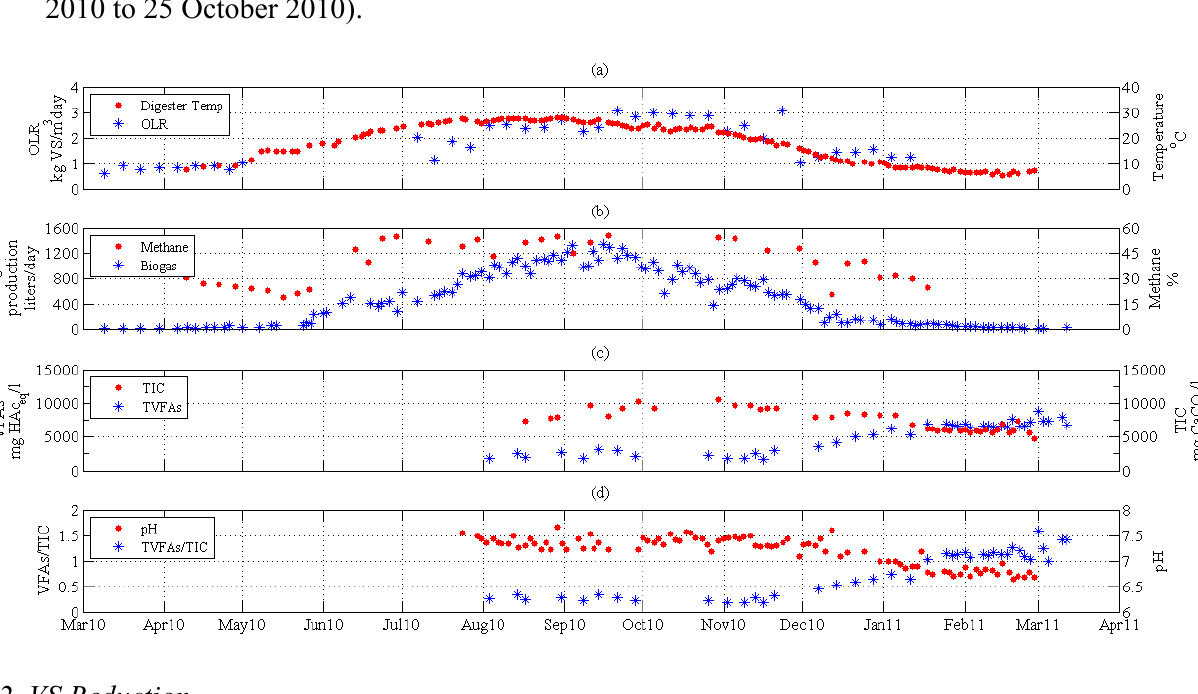
Figure 2. Digester operational conditions. ( a ) OLR and Temperature; ( b ) Biogas production and Methane Concentration; ( c ) Volatile Organic Fatty Acids (VFAs) and Total